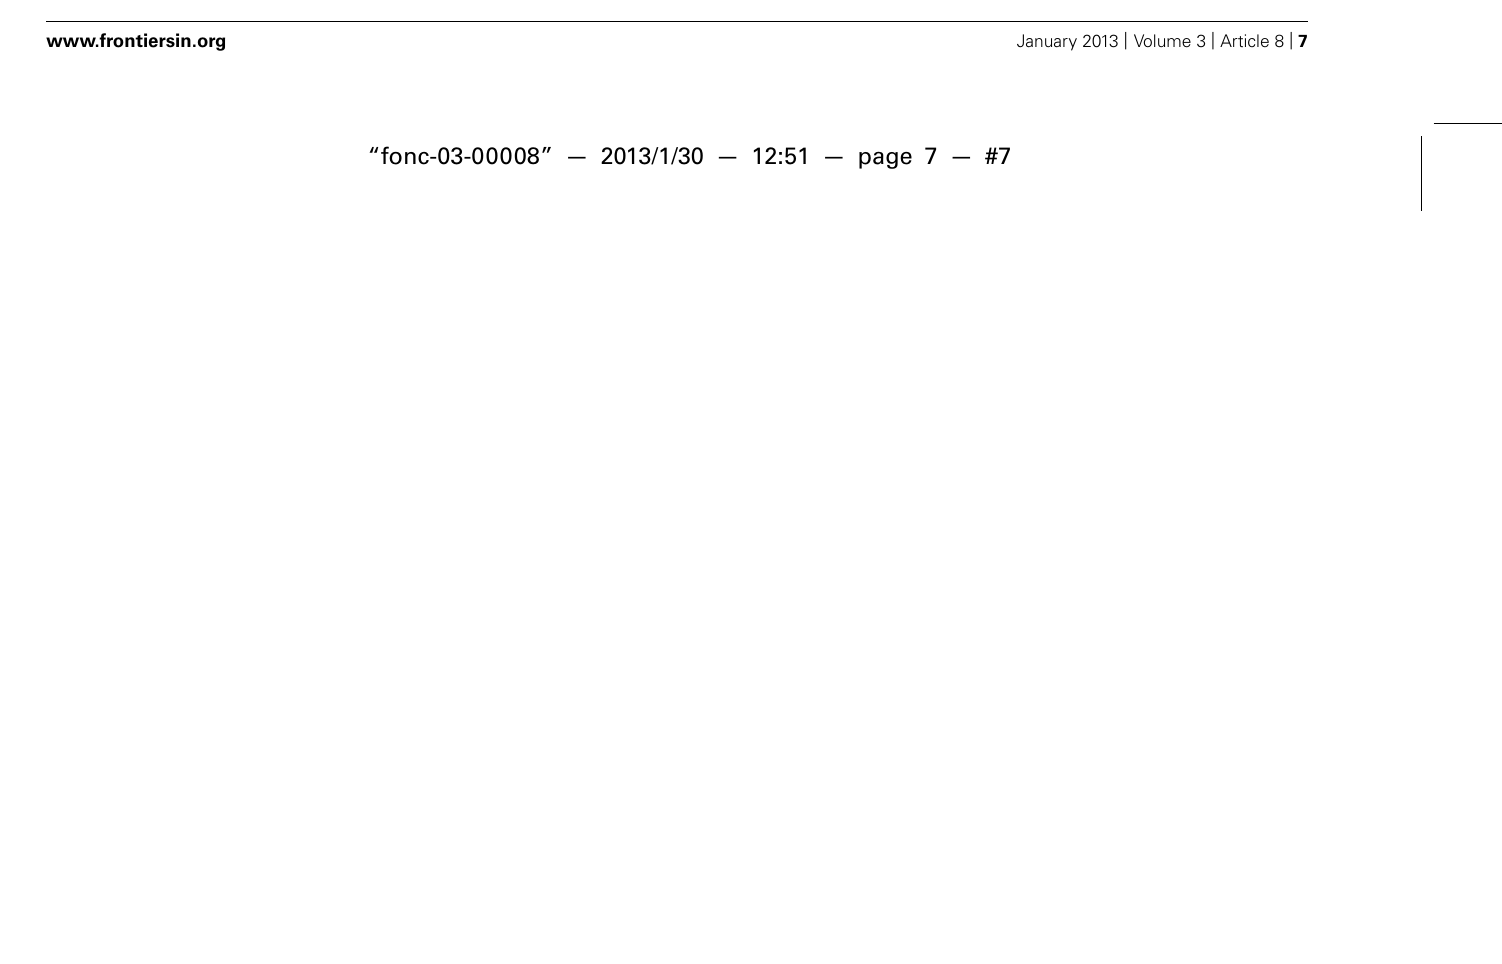
dephosphorylates p53 at S46 andT55. (J) Wip1 and PP1 dephosphorylate Mdm2 at S395, which facilitates p53 degradation. (K) PP1 interacts with BRCA1 and dephosphorylates multiple sites of BRCA1. In addition to acting as a PP1 substrate, BRCA1 also plays a role in PP1 inhibition. (L) KAP-1 is dephosphorylated at S473 by PP1 and PP4, whereas S824 is dephosphorylated by PP4. (M) PP2A and PP4 are required for RPA2 dephosphorylation. (N) Phosphorylated 53BP1 is recruited to DNA damage sites to coordinate the localization of DDR factors and promote their activation. PP5 dephosphorylates 53BP1 at S1778, leading to 53BP1 release from DNA damage sites.